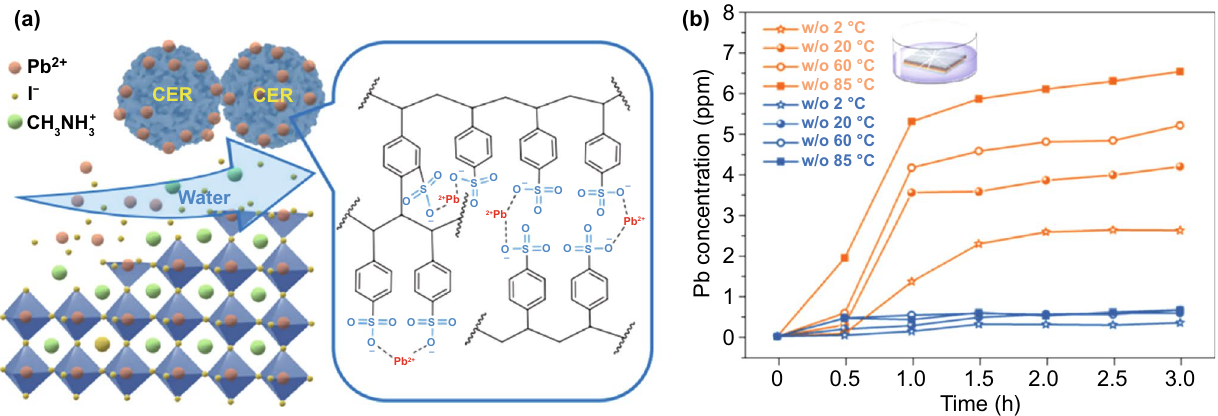
Fig. 5 a Illustration of how CERs prevent the lead leakage via strong ionic interaction between Pb 2+ cations in broken perovskite films and the sulfonate groups. b Pb-soaking test results in water for the damaged perovskite solar modules without (yellow line) and with (blue line) the CER coating layer on glass side. Reproduced with permission from Ref. [50] Copyright 2020 Nature Publishing